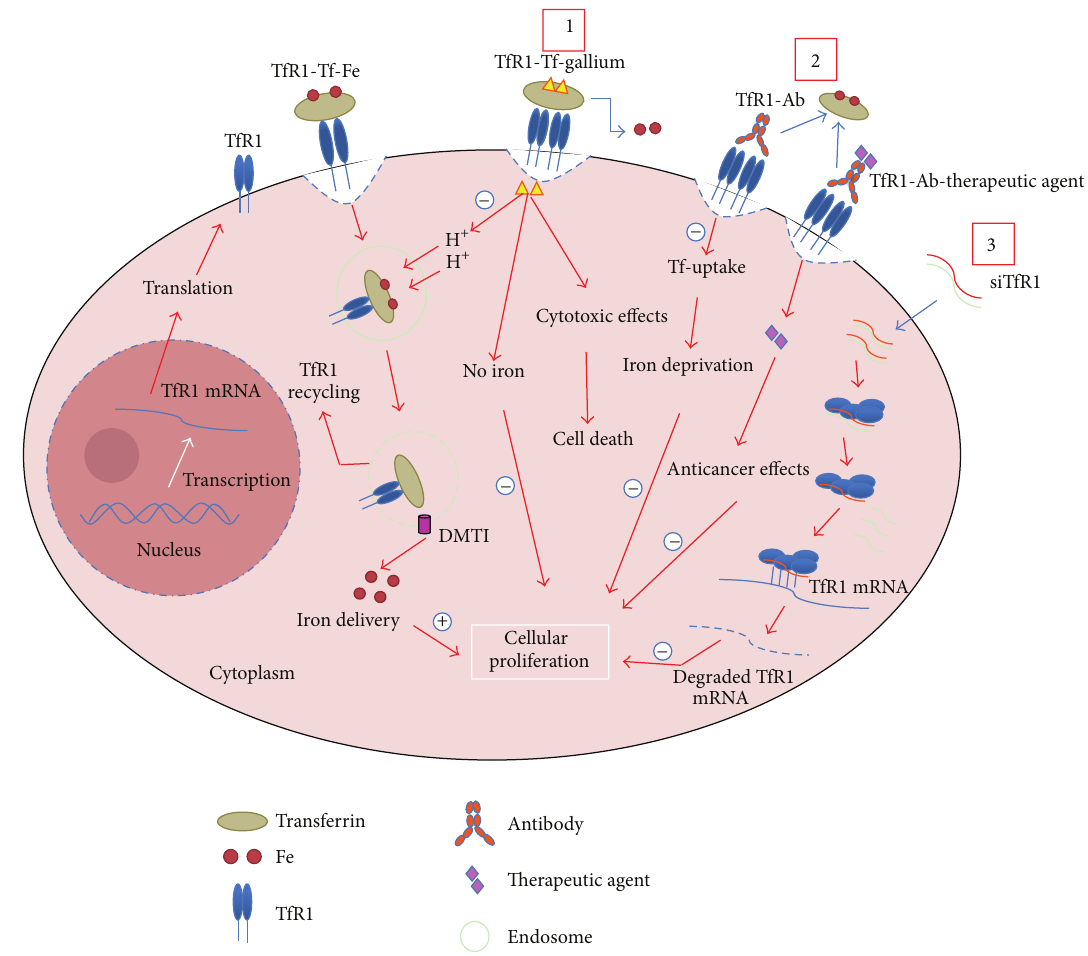
Figure 5: The diagram shows cellular uptake of iron by internalizing the transferrin-iron complex through TfR1-mediated endocytosis and summarizes the main therapeutic strategies through TfR1. 1: gallium binds avidly to transferrin, competing with iron (Fe), to form transferrin- gallium complexes, which in turn binds TfR1/CD71 on the surface of neoplastic cells containing high density of TfR1. Gallium, delivered in the cytoplasm, may be capable of interfering with the intracellular release of iron from the endosome to cellular compartments. Gallium also has direct cytotoxic effects resulting in cell death. 2: monoclonal antibody (Ab) against TfR1 binds TfR1 on the cell surface overexpressing the receptor, like in tumor cells, by competing or not with Fe-transferrin complexes depending on the location of the epitope on the receptor to which the antibody binds. This activity, in turn, results in iron deprivation and cell proliferation inhibition. Other types of antibodies have been engineered to deliver therapeutic agents with anticancer effects. 3: small interfering RNA (siRNA) approach. siRNA, alone or complexed, by transit across cellular membrane, are delivered to cytoplasm, where by classical Dicer-RISC-pathway-unwinding-mRNA recognition- cleavage-mRNA degradation could drive TfR1 downregulation. Both three proposed mechanisms potentially conduct to the reduction of iron in the cytoplasm of neoplastic cell and thus to the inhibition of cellular